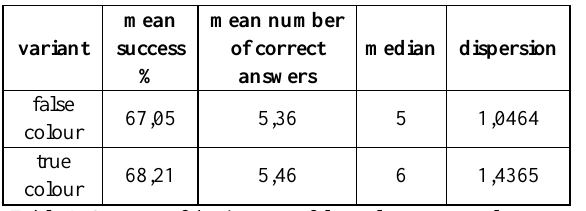
Table 3. Success of the images - false colour - true colour: